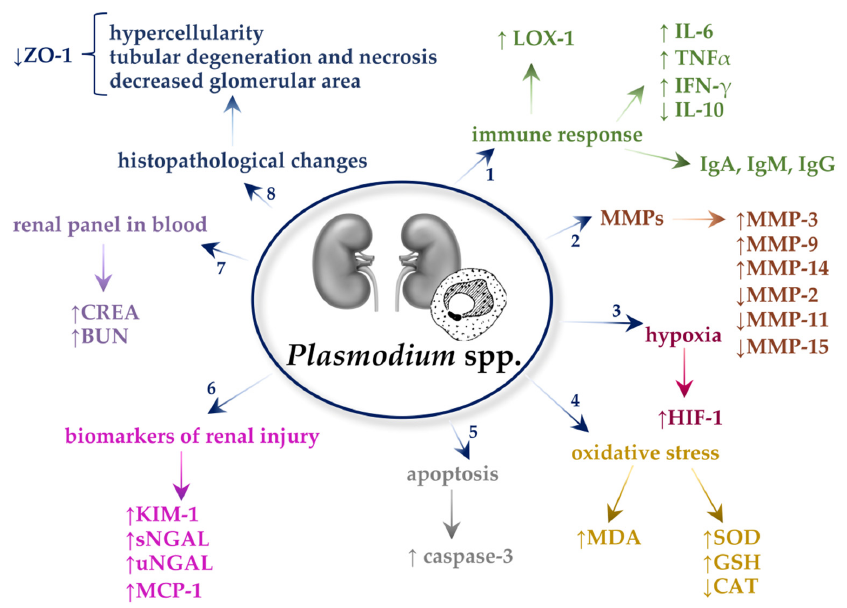
Figure 2. Mechanisms in Plasmodium spp.-infected kidneys. 1. Plasmodium spp. increase the expression of lectin-like oxidized low-density lipoprotein receptor 1 (LOX-1), and they also affect the growth of interleukin-6 (IL-6), tumor necrosis factor- α (TNF- α ), and interferon- γ (IFN- γ ). It was found that Plasmodium spp. decrease the level of the anti-inflammatory cytokine IL-10. The deposition of immunoglobulin (Ig)A, IgM, and IgG was reported in the glomeruli of mice infected with Plasmodium spp. 2. Malaria causes an increase in matrix metalloproteinase (MMP)-3, MMP-9, and MMP-14 and a decrease in MMP-2, MMP-11, and MMP-15. 3. The Plasmodium spp. infection causes hypoxia in the kidneys by increasing the hypoxia-inducible factor 1 (HIP-1). 4. Plasmodium spp. cause oxidative stress manifested by an increase in malondialdehyde (MDA) and an increase in superoxide dismutase (SOD), as well as reduced glutathione (GSH) and a decrease in catalase (CAT). 5. Plasmodium spp. cause an increase in caspase-3 activity, the main enzyme in the process of apoptosis. 6. Biomarkers, which increase in nephropathy caused by Plasmodium spp., are serum and urine neutrophil gelatinase-associated lipocalin (sNGAL and uNGAL, respectively) and monocyte chemoattractant protein-1 (MCP-1) and kidney injury molecule 1 (KIM-1) in kidneys. 7. Plasmodium spp. cause an increase in creatine (CREA) and blood urea nitrogen (BUN) levels in the blood of hosts. 6. The parasites cause hypercellularity, tubular degeneration, and necrosis and also decreased glomerular area, which may be caused by decreased tight junction-associated protein, zonula occludens-1 (ZO-1) in the kidneys. 4. Toxoplasma gondii Toxoplasmosis is a zoonotic parasitic infection caused by Toxoplasma gondii , an obligate, intracellular, apicomplexan protozoa. Toxoplasmosis is a parasitic disease widely distributed throughout the world [112,113]. The parasite has two hosts in its life cycle. The definitive hosts are members of family Falidae, while the intermediate hosts are mostly many mammals and birds [114]. T. gondii is transmitted by ingestion of water, fruits, and vegetables contaminated with sporulated oocysts; through consumption of tissue cysts in undercooked meat of an infected animal; congenitally via the placenta; through blood transfusion; and from organ transplant [112,114]. Toxoplasmosis in immunocompetent individuals is mostly asymptomatic, or with non-specific flu-like symptoms, but a burgeoning number of epidemiological studies suggest that the parasite can be associated with several long-term behavioral effects [115]. The infection is considered to be an opportunistic and life-threatening disease in immunocompromised people, pregnant women, and newborns. Primary T. gondii infection during pregnancy can result in congenital toxoplasmosis with abortion, neonatal death, chorioretinitis, and neurological disorders in neonates [116]. In immunosuppressed patients, the involvement of many organs and systems can occur following the infection. Most cases of toxoplasmosis in immunosuppressed patients result from secondary reactivation of latent infection because parasites are formed as a tissue cyst in many organs. It has been found that T. gondii has a tropism to the kidneys. The large number of